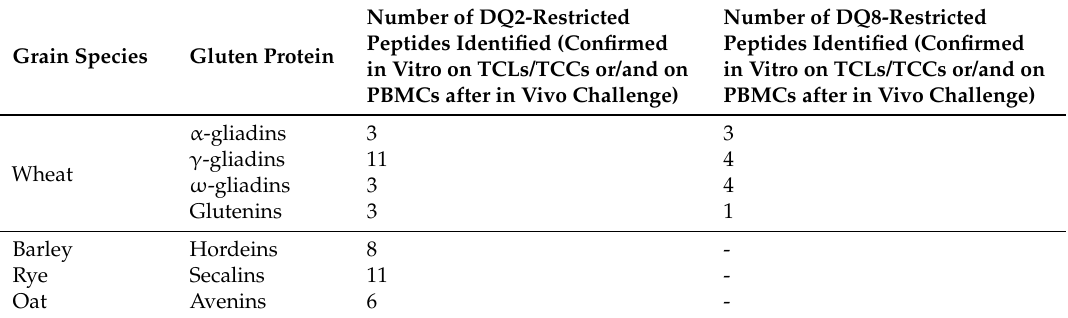
Table 3. Number of gluten immunogenic peptides currently identified within distinct gluten